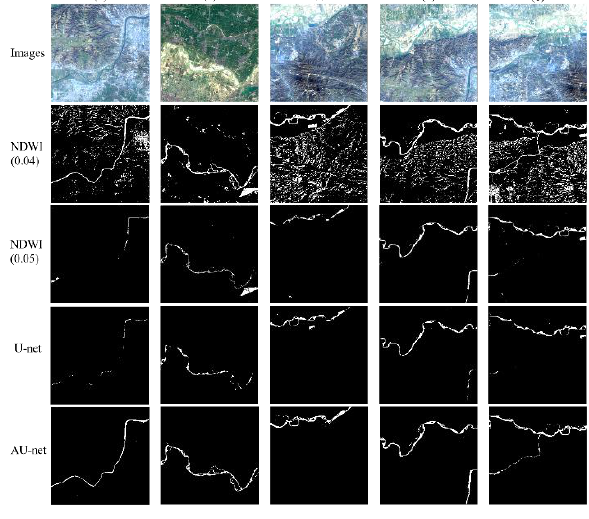
Fig.5. The results of river